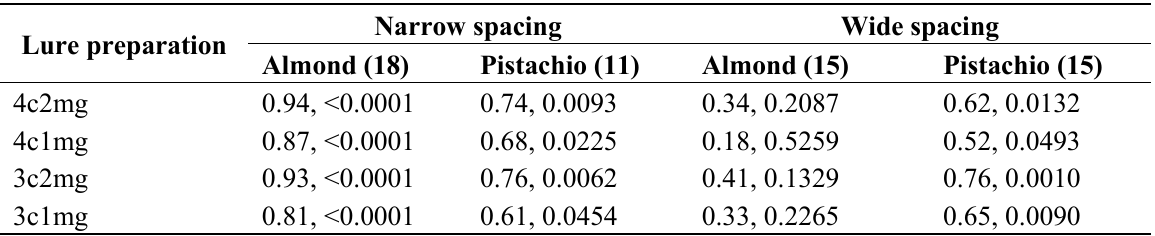
Table 2. Correlation (Spearman ρ, p ) of males captured in lure-baited traps with males captured in traps baited with calling females with traps spaced either narrowly (7 m) or widely (60 m) in almonds or pistachios.